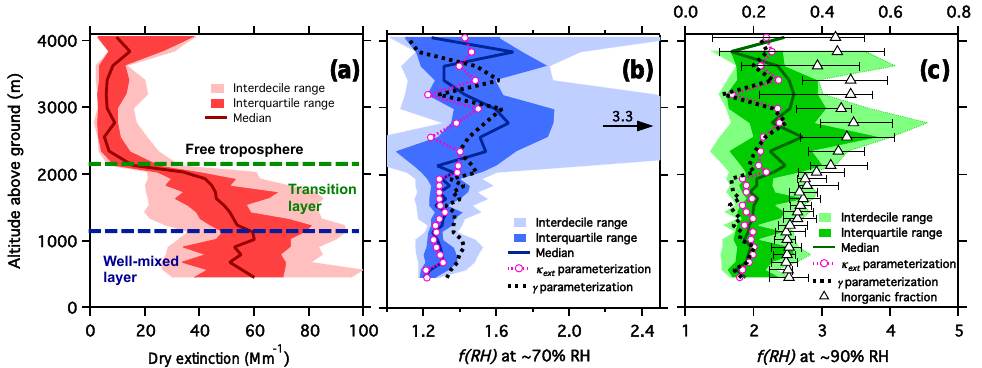
Figure 4. Composite vertical profiles of (a) dry extinction, (b) f (RH) at ∼ 70% RH, and (c) f (RH) at ∼ 90% RH. Shaded areas represent the interdecile and interquartile ranges. The dashed horizontal lines in (a) show the boundary between the well-mixed and transition layers and between the transition layer and free troposphere, as defined by Wagner et al. (2015). The circles and dashed lines in (b) and (c) show the mean f (RH) values determined by fitting the κ ext and γ parameterizations, respectively, to the raw data before altitude binning and averaging. The triangles in (c) show the fraction of sub-0.7µm aerosol mass measured by the AMS that is inorganic (top axis); error bars show the interquartile range.